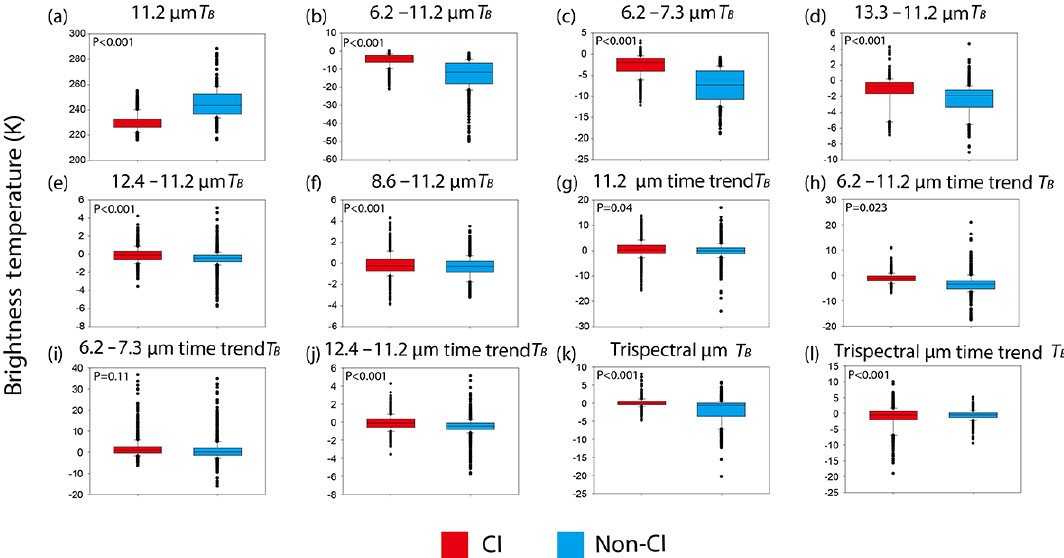
Figure 2. Box plots of 12 input variables (i.e. interest fields) generated based on the reference data used for CI detection models: (a) 11.2µm T b , (b) 6.2–11.2µm T b , (c) 6.2–7.3µm T b , (d) 13.3–11.2µm T b , (e) 12.4–11.2µm T b , (f) 8.6–11.2µm T b , (g) 11.2µm time trend T b , (h) 6.2–